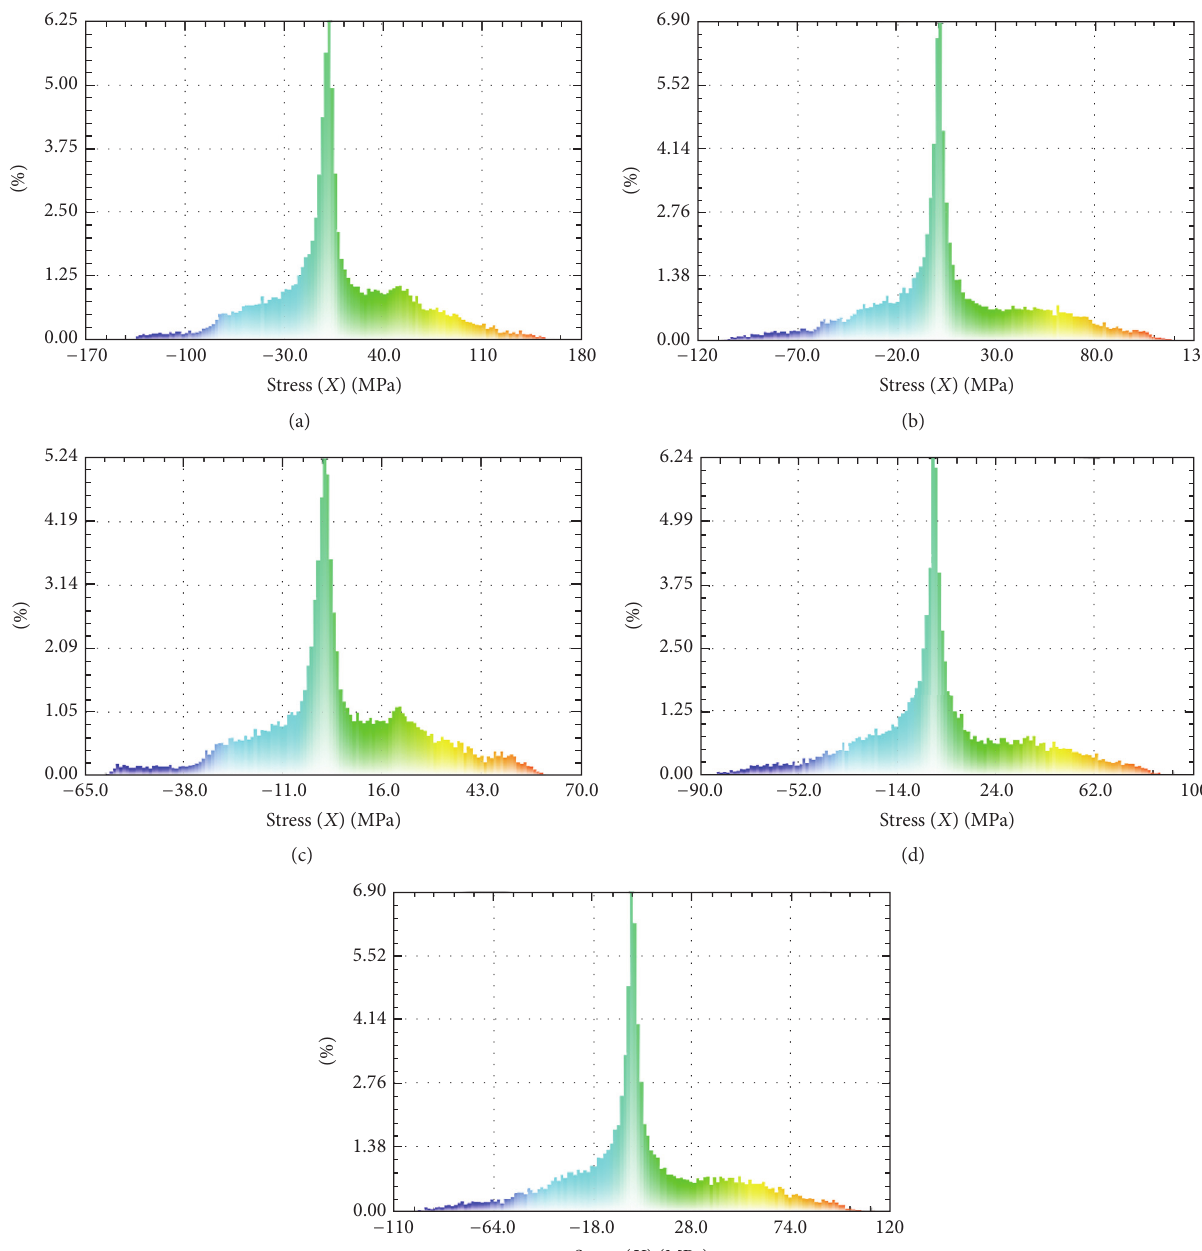
Figure 6: Results of residual stress ( 𝑋 ) distribution for different compression value: (a) quenched; (b) 1%; (c) 2.5%; (d) 4%; (e) 5%.